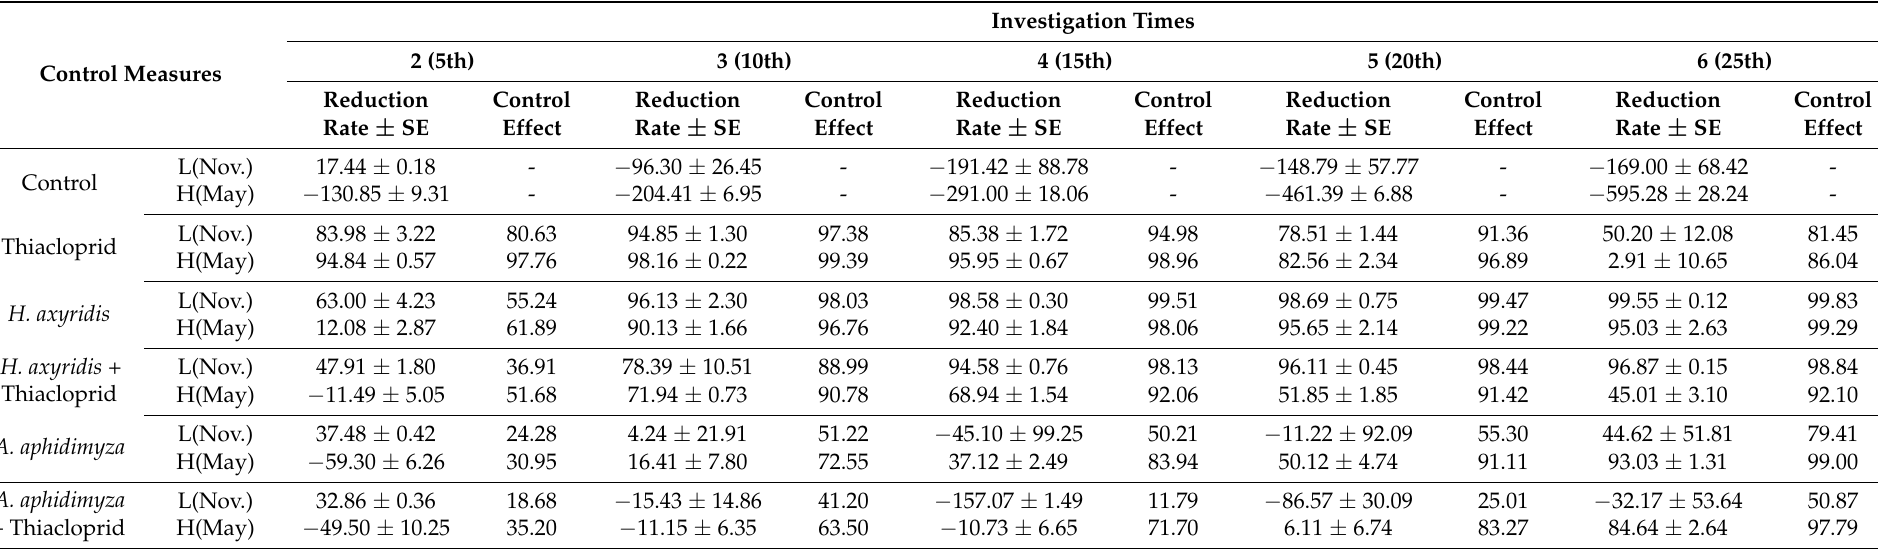
Table 5. Pest control effect of M. persicae populations under different treatments, compared to the untreated control, on pepper seedlings set up in field cages of 90 cm × 90 cm × 90 cm within a greenhouse. L = low temperature (the dates of each investigation time were 5 November, 10 November, 15 November, 20 November, 25 November); H = high temperature (the dates of each investigation time were 5 May, 10 May, 15 May, 20 May, 25